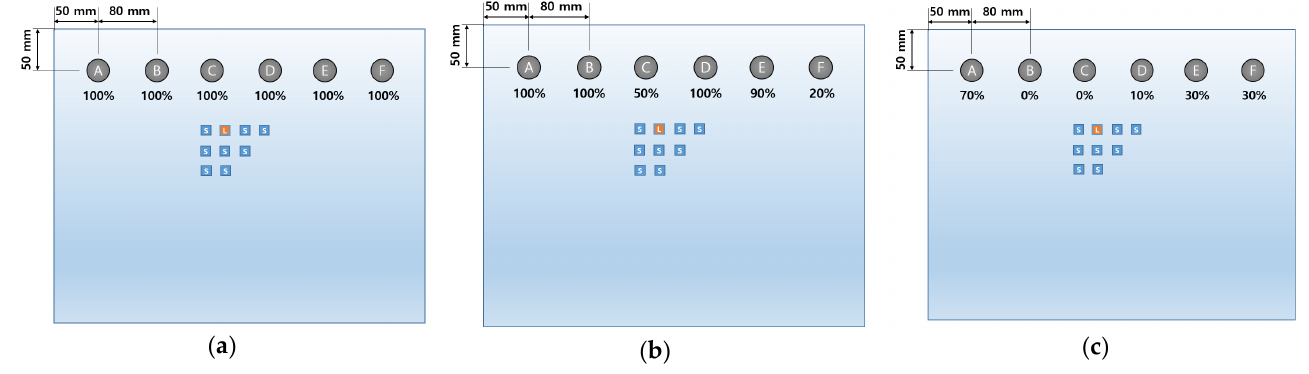
Figure 23. ( a ) Classification accuracy for six defect locations which is trained by whole data set; ( b ) classification accuracy for six defect locations. The training data set is collected by shifting location of defect data sets; ( c ) classification accuracy for six defect locations. The training data set is collected by shifting location of defect data sets.